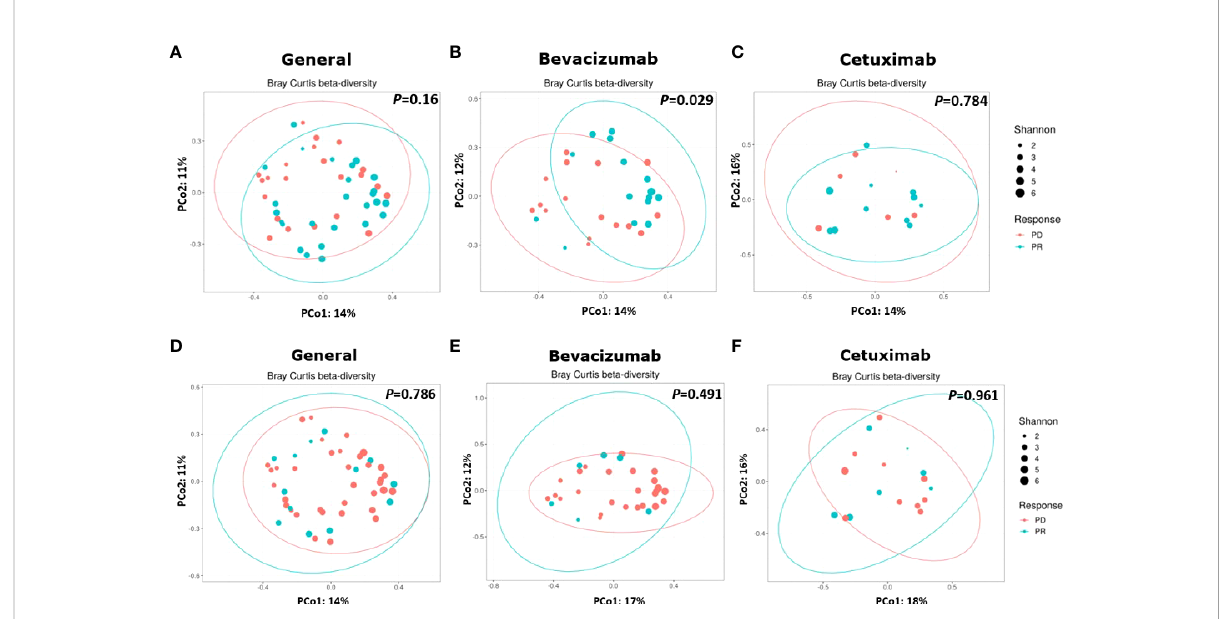
FIGURE 3 Results on b -diversity of treatment groups and subgroups. (A) b -diversity did not signi fi cantly differ between the PD and PR groups ( P = 0.16); (B) Bacterial species signi fi cantly different between the bevacizumab-PD and PR subgroups ( P = 0.029). (C) b -Diversity did not signi fi cantly differ between the cetuximab-PD and PR subgroups ( P = 0.784). (D) b -diversity did not signi fi cantly differ between the substantial diarrhea and minor or no diarrhea groups ( P = 0.786). (E, F) b -diversity did not signi fi cantly differ between the bevacizumab ( P = 0.491) and cetuximab ( P = 0.961)